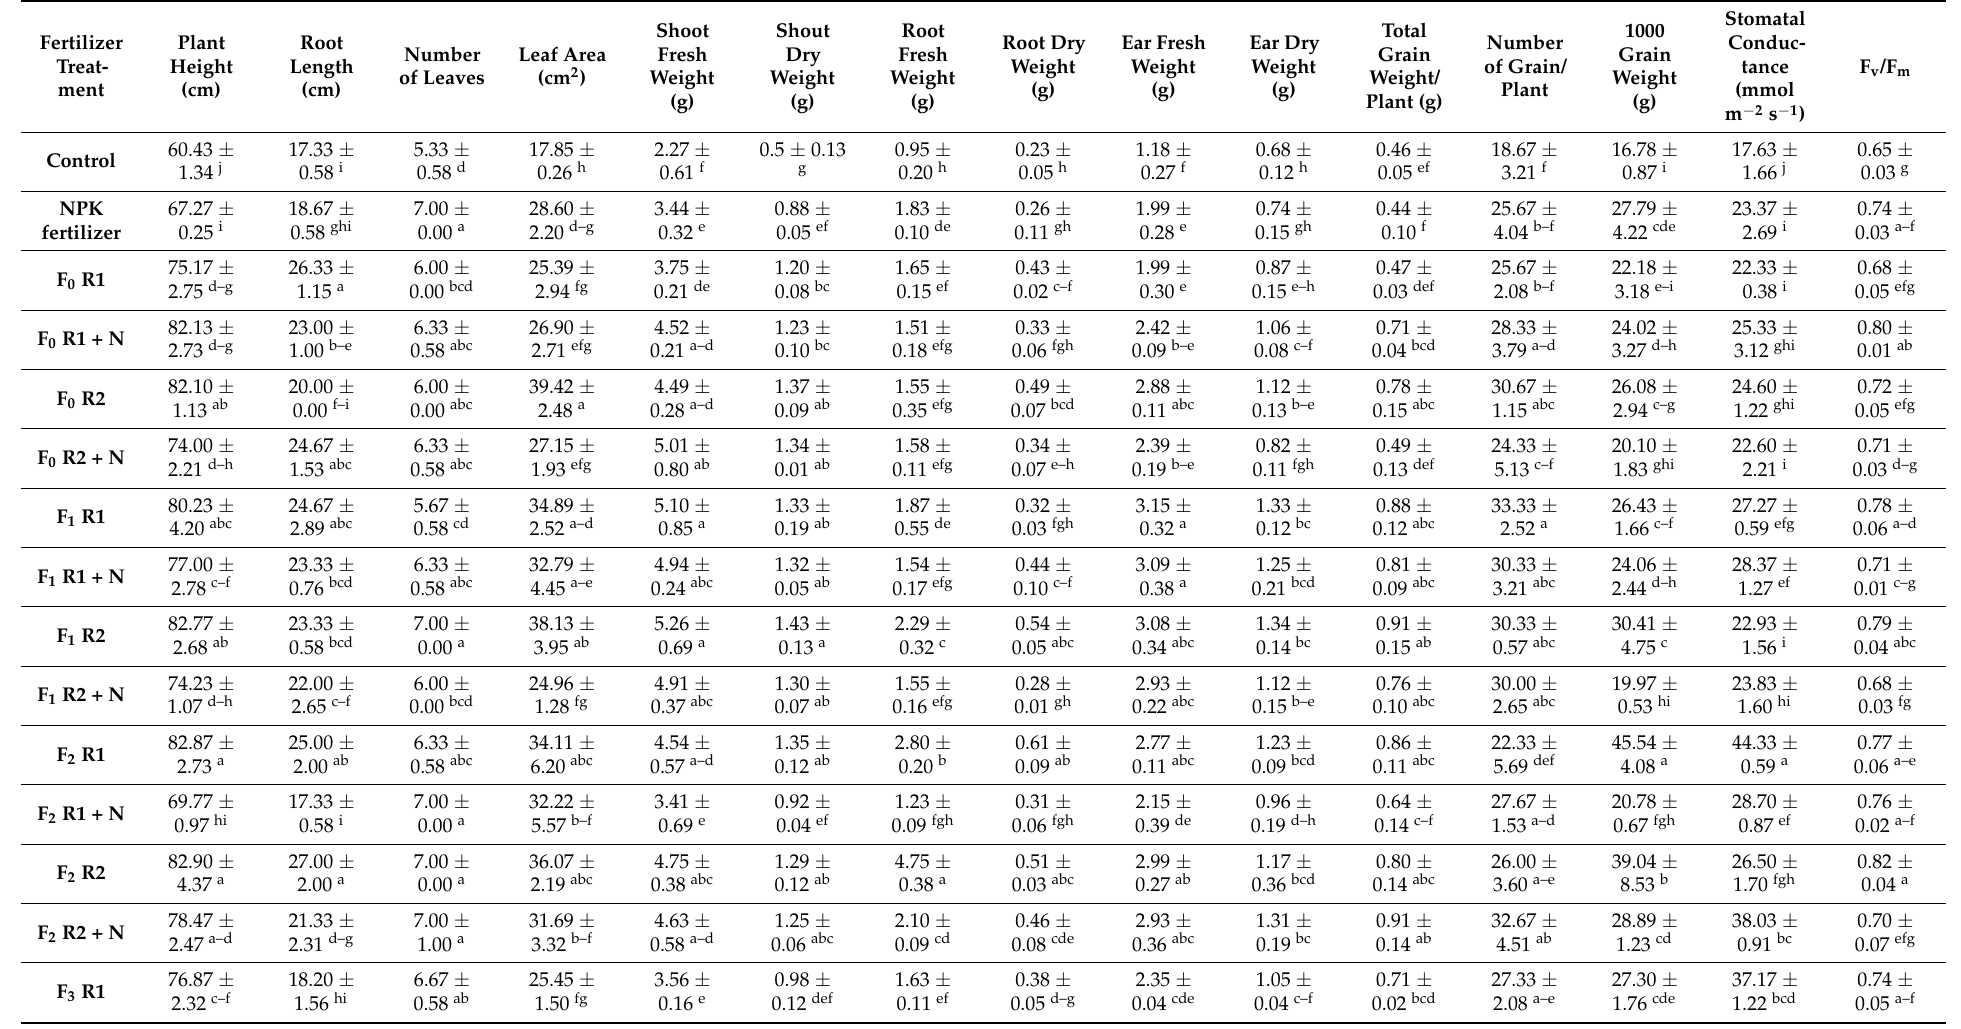
Table 6. Effects of vitreous fertilizers on the growth, physiology, and yield of wheat after four months of